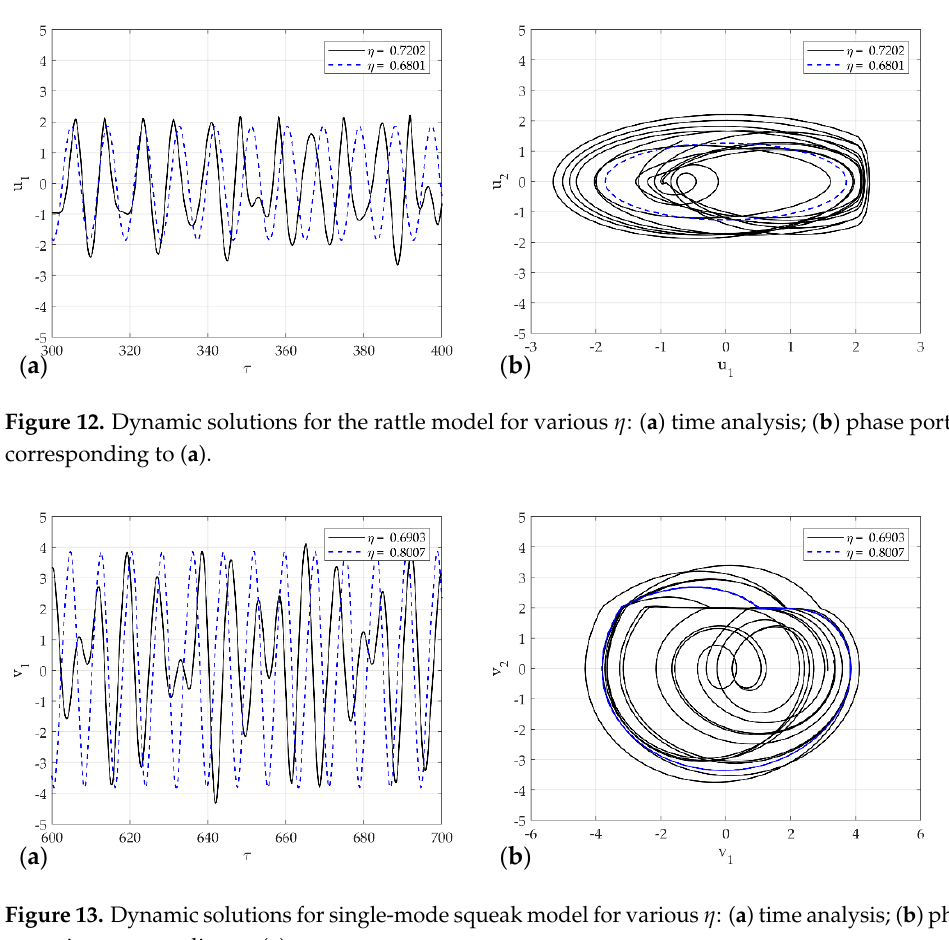
multi-mode squeak models, respectively. Figure 12a,b shows the time series plot and